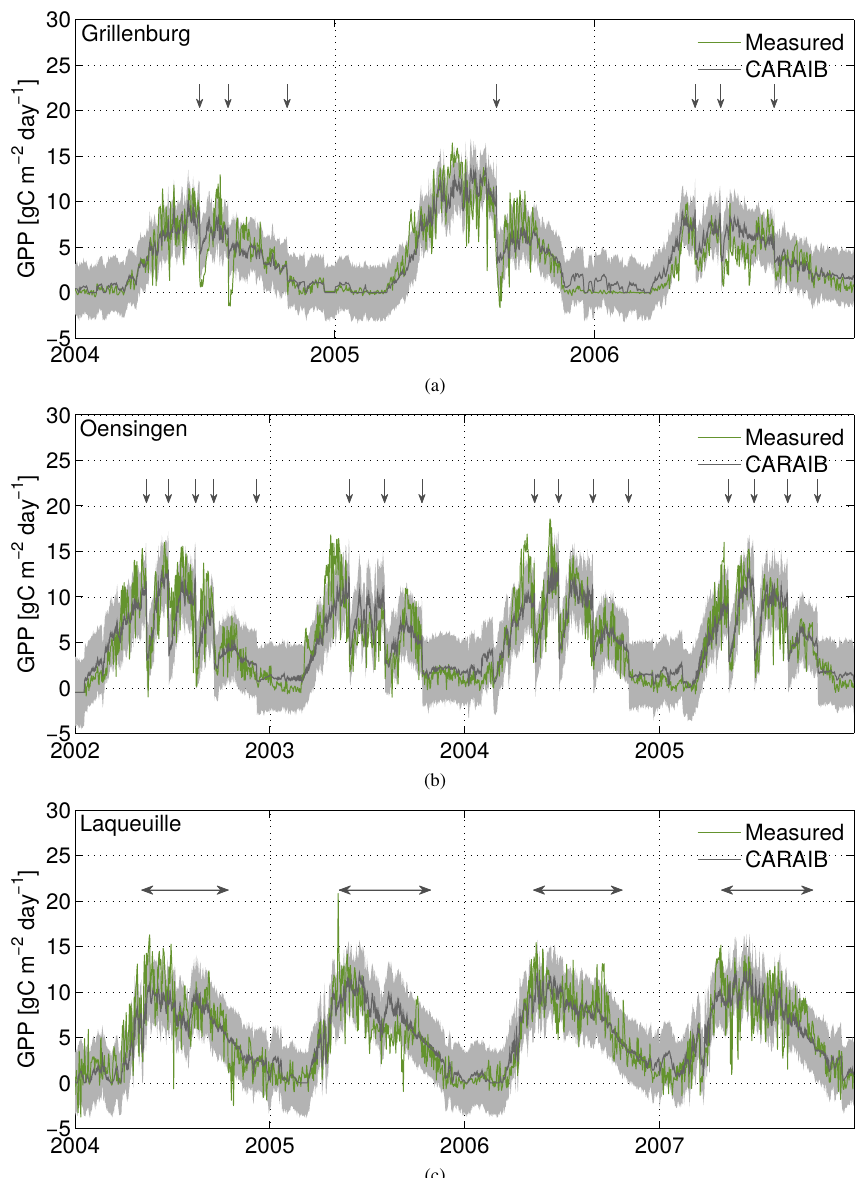
Figure 4. Measured and modelled GPP (gCm − 2 day − 1 ) for the Grillenburg (a) , Oensingen (b) and Laqueuille (c) experimental sites. See Fig. 3 (a) for Monte Bondone. The ranges of the prediction uncertainty due to parameter uncertainty and the 95% total predictive uncertainty are depicted by the dark and light grey shaded areas, respectively. Vertical arrows indicate the dates of the grass cutting (Grillenburg and Oensingen) and horizontal arrows the periods of grazing